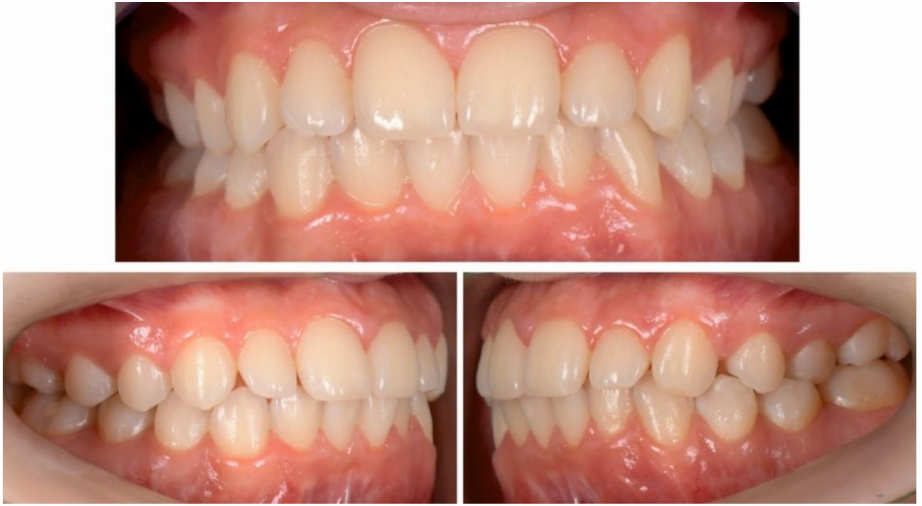
Figure 24. Intra-oral aspect at the one-year follow-up